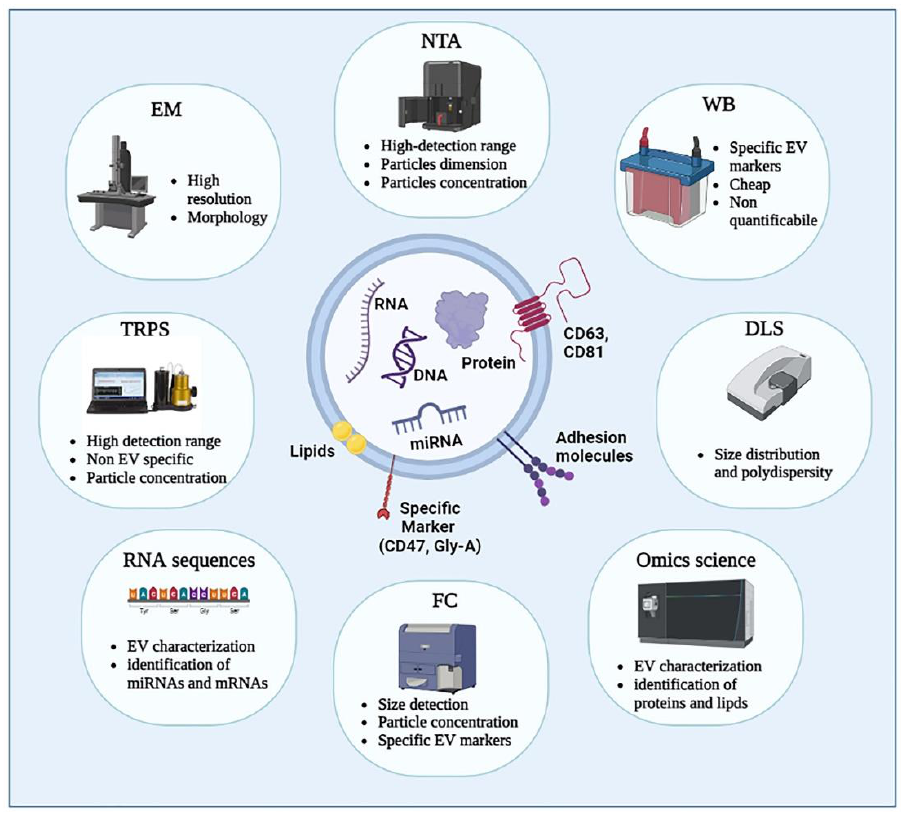
Figure 3. Summary of the different methods for characterization and quantification of EVs. The characterization and quantification of EVs are performed through different techniques such as nanoparticle tracking analysis (NTA), flow cytometry (FC), Western blot (WB), transmission electron microscopy (TEM), and scanning electron microscopy (SEM). TEM analyzes EV diameters and morphology. Dynamic light scattering (DLS) determines EV size distribution and polydispersity by detecting the diffusion coefficient of the scattering EVs. NTA detects EV dimensions and concentrations through scattered light measurement and Brownian motion. RNA sequences and mass spectrometry permit cargo characterization. In particular, FC can be employed for size detection, particle concentration, and EV-specific markers. Tunable resistive pulse sensing (TRPS) only measures particle concentration. Created in Biorender.com, accessed on 6 December 2022.